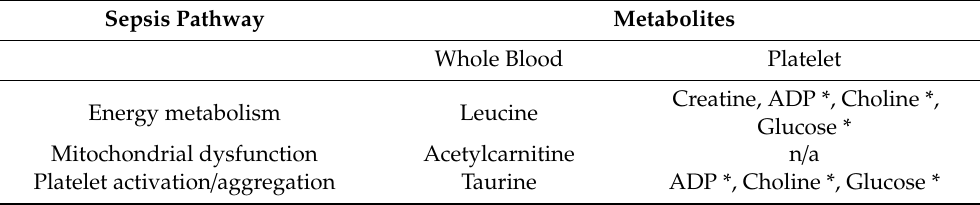
Table 4. Selected Metabolites Biological Relevance to Sepsis.